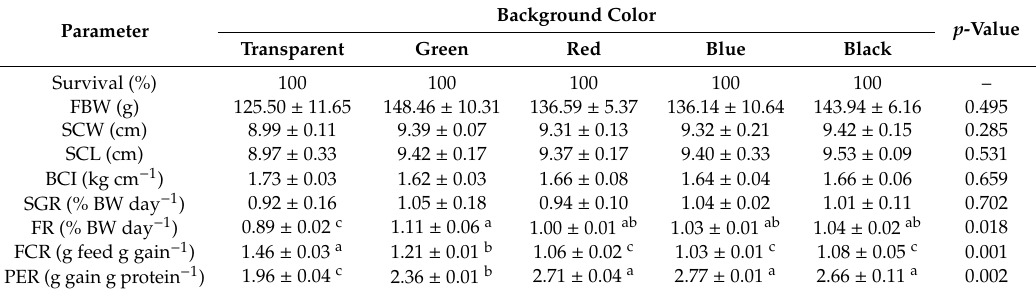
Table 1. Survival, growth performance, and feed utilization of northern river terrapin reared with various background colors. The sampling represents the end of the twelve-week experiment. Background Color p -Value Parameter Transparent Green Red Blue